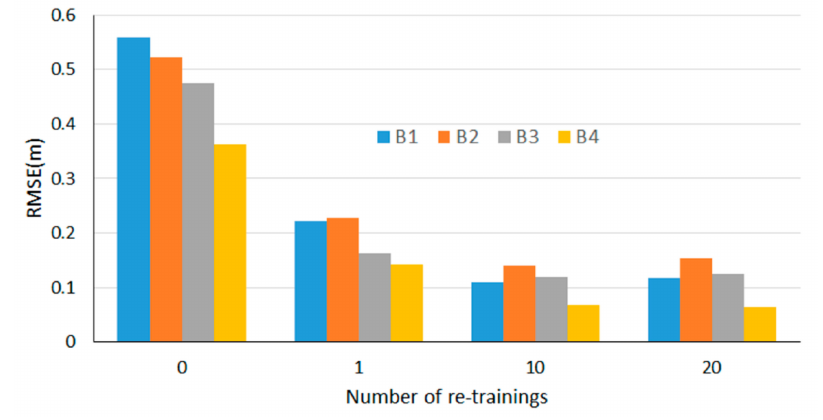
Figure 9. Error evaluation of the number of retrainings using CNN transfer learning.